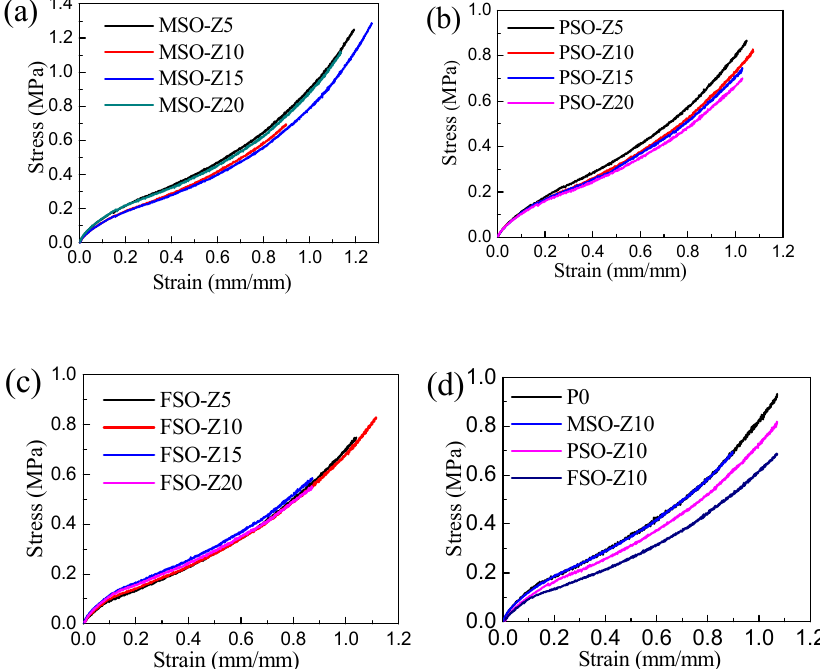
Figure 10. Tensile stress–strain curves of silicone coatings: ( a ) MSO/PDMS coating, ( b ) PSO/PDMS coating, ( c ) FSO/PDMS coating, ( d ) different silicone oil/PDMS coatings.